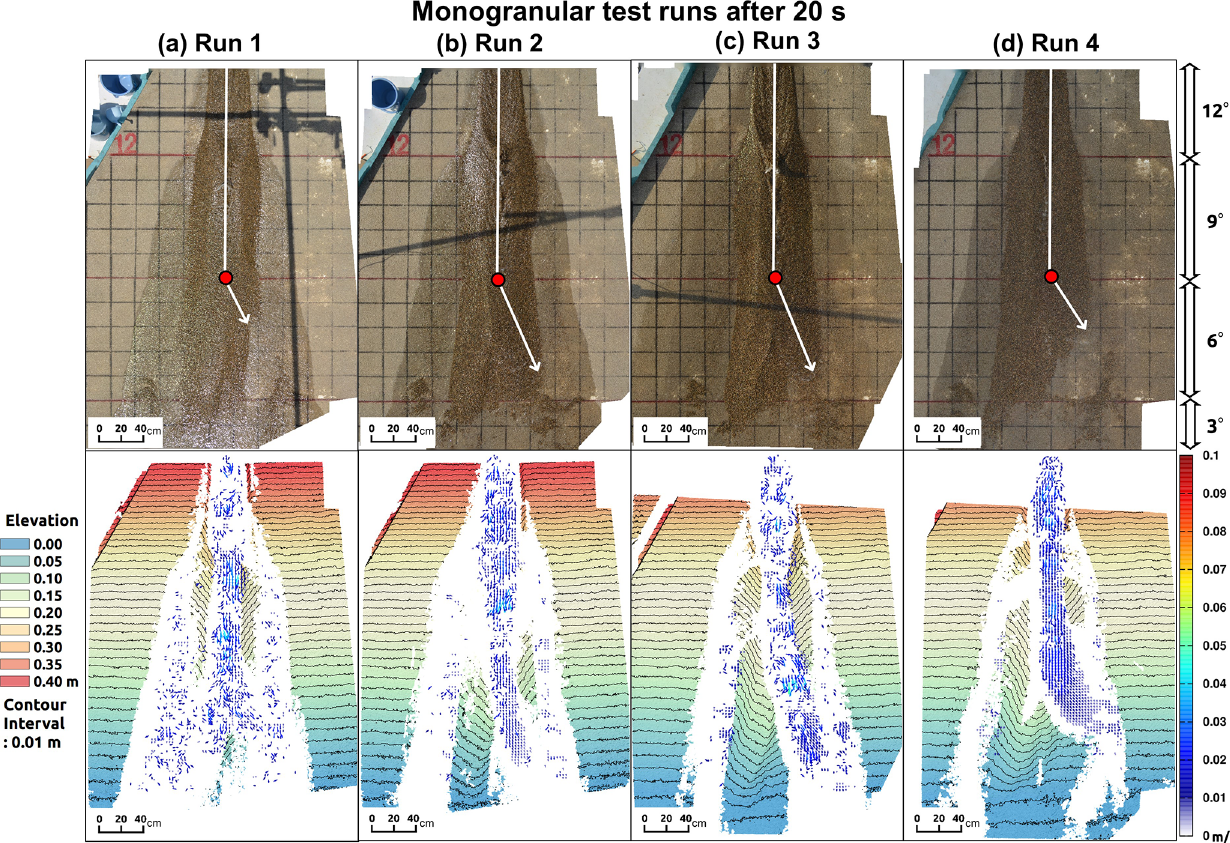
Figure 8. Fan morphology 20s after the start of runout of the monogranular flows. The upper and lower panels show orthophotos and digital elevation models (DEMs) with flow vectors, respectively. Respective sets of the upper orthophoto and lower DEM represent corresponding results of each experimental test run. The white arrows on the orthophotos indicate the assumed principal direction of flow descent. The red points in the orthophotos indicate the assumed occurrence point of the avulsion. The elevation of the DEMs is depicted assuming that the area with a 3 ◦ slope (i.e., the area furthest downstream from where the slope angle changed from a 6 to 3 ◦ slope) has elevation of